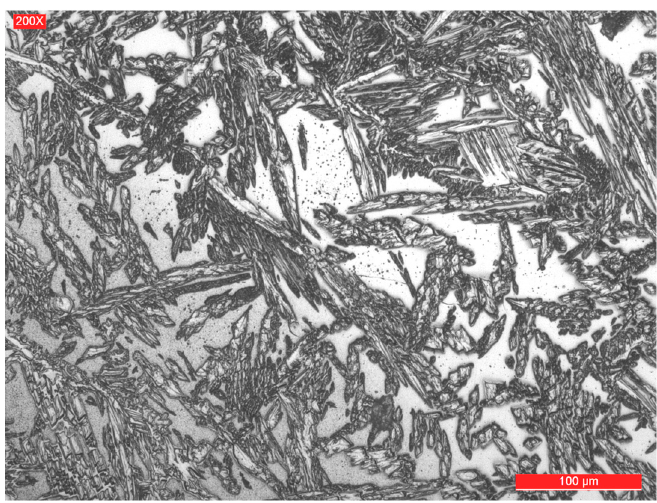
Figure 6. Microstructure of the root layer.